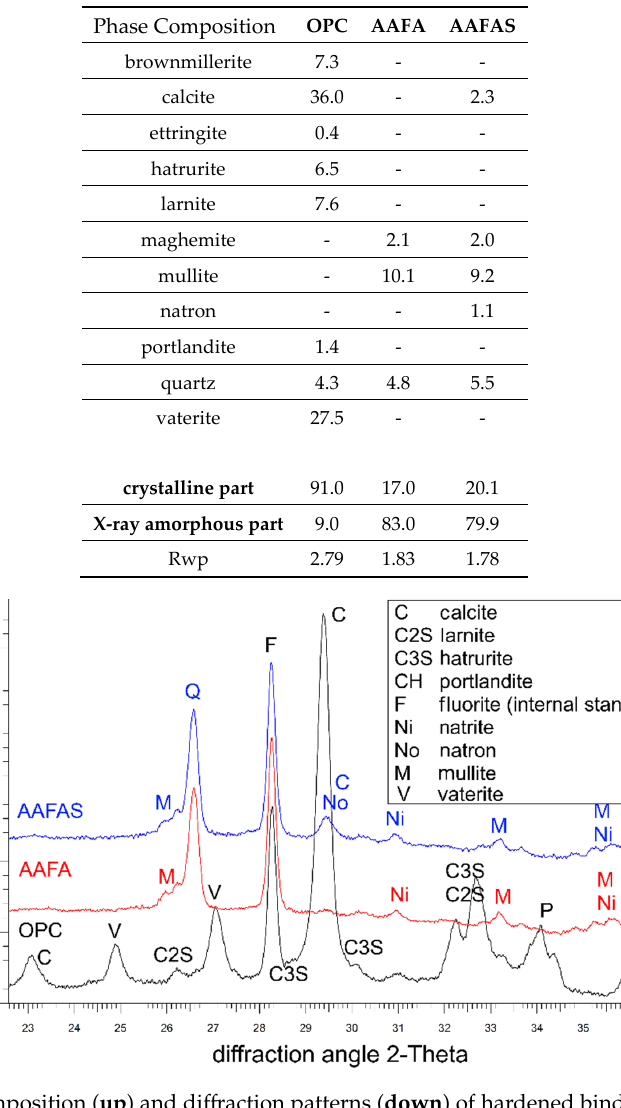
Figure 2. Depth of non-pink colored material in concrete were stored at 20 °C/65% rH, 0.04 Vol.-% CO 2.